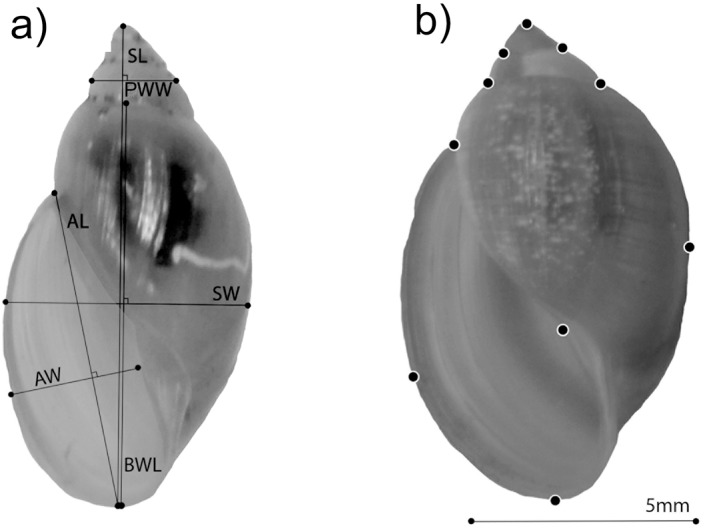
Example shells from (a) Physa carolinae and (b) Physa acuta.The six linear measurements are shown on shell a: Shell length (SL), shell width (SW), body whorl length (BWL), penultimate whorl width (PWW), aperture length (AL) and aperture width (AW). The 11 landmarks are located on shell b. Landmark points follow Dunithan et al. [47] and include points to capture the apex, aperture, lip, body whorl, and spire whorls. Landmarks on main body whorl and aperture lip were treated as sliding semilandmarks.